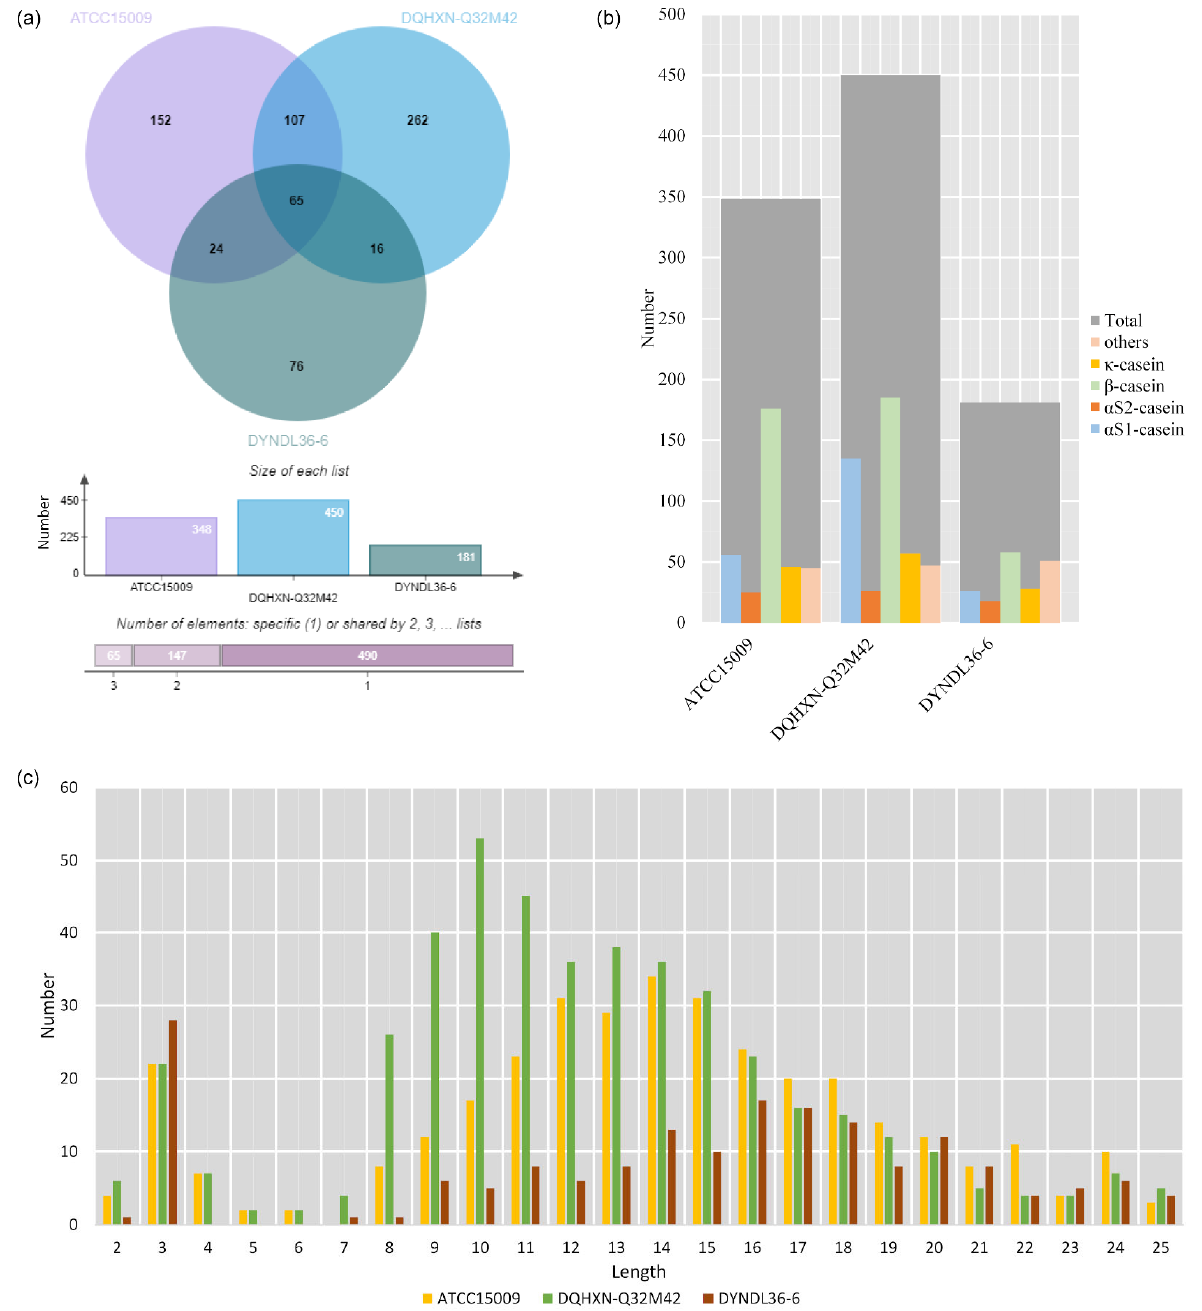
Figure 2. Set analysis of peptidomics data. ( a ) Venn diagram of the peptidomics of fermented milks by Lactobacillus helveticus . The top figure is a classical Venn diagram, the middle figure shows the number of peptides in every sample, and the bottom figure lists the numbers of common peptides and unique peptide. ( b ) Peptide source protein distribution map of the identified peptides. ( c ) Peptide length distribution map.